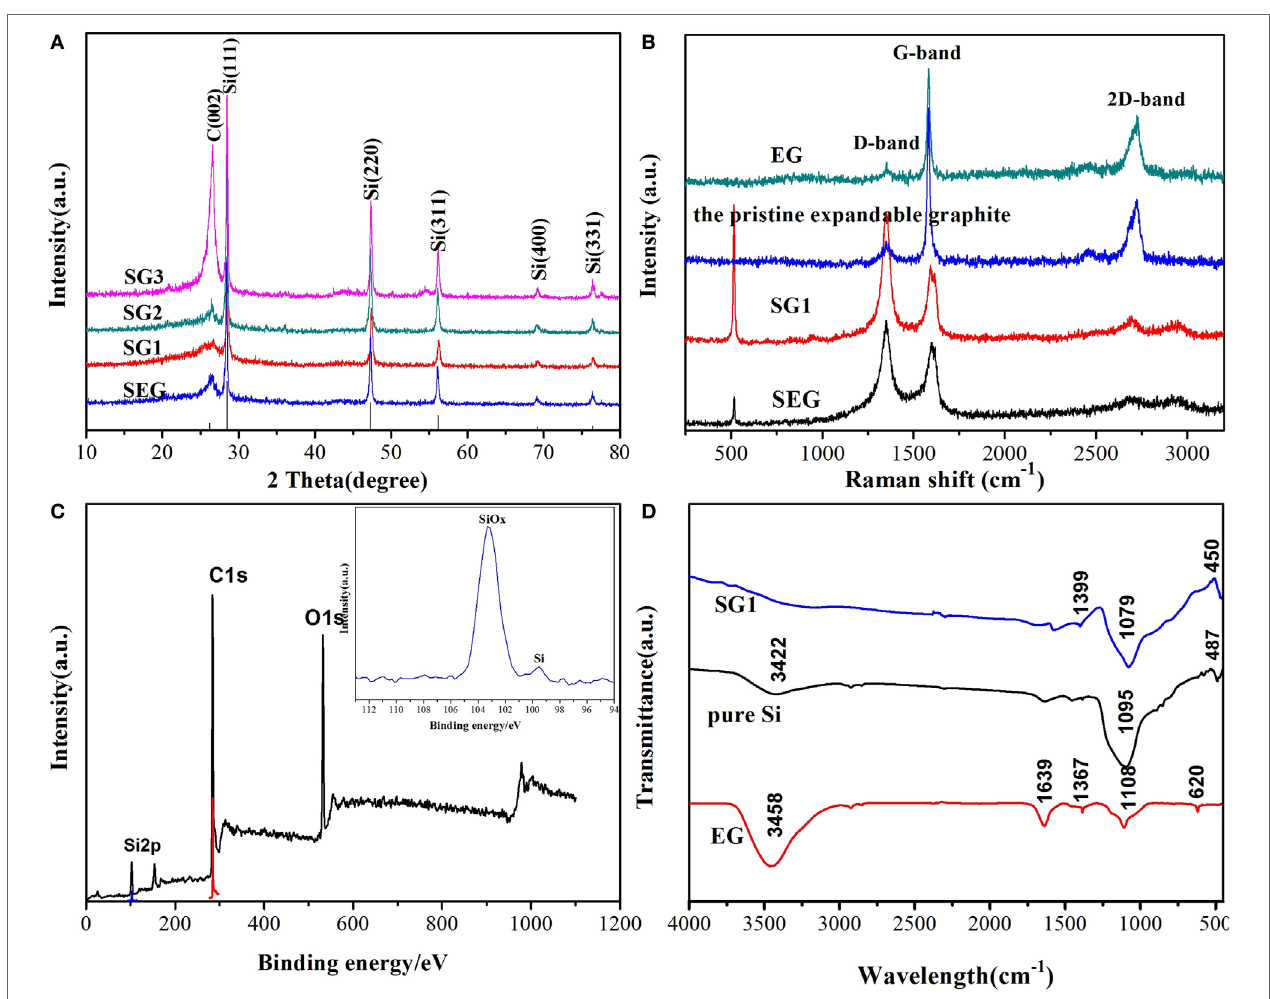
FigUre 2 | X-ray diffraction spectra of SG1, SG2, SG3, and Si@SiO x /expandable graphite (SEG) (a) , Raman spectra of pristine expandable graphite, expanded graphite (EG), SG1, and SEG (B) , X-ray photoelectron spectroscopy spectra of SG1 with the high-resolution spectrum of Si 2p (inserted) (c) , FT-IR spectra of EG, Si nanoparticles, and SG1 (D)